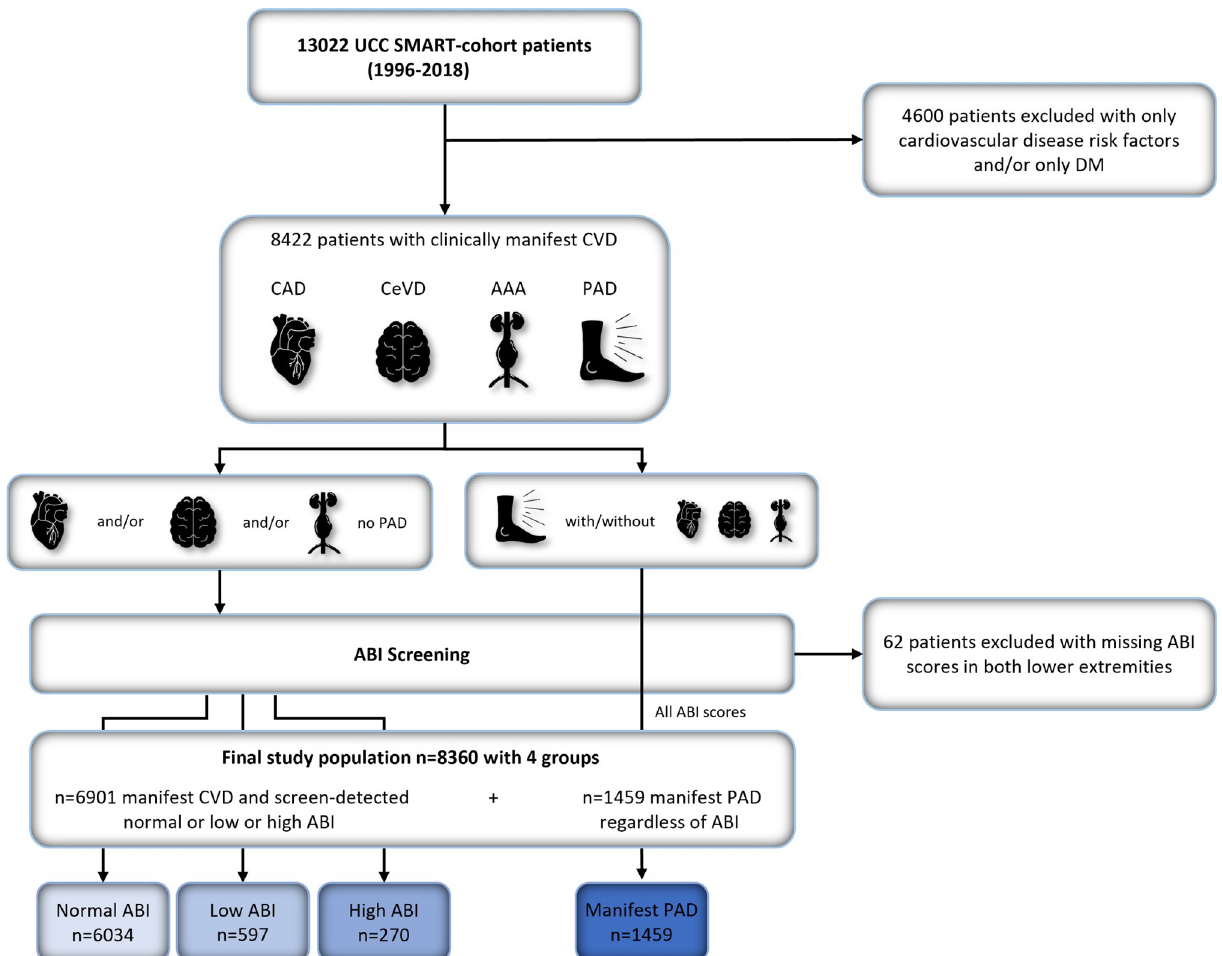
Fig 2. Flowchart of the study population. Abbreviations: UCC-SMART = Utrecht Cardiovascular Cohort Second Manifestations of ARTerial disease, DM = diabetes mellitus, CeVD = cerebrovascular artery disease, CAD = coronary artery disease, AAA = abdominal aortic aneurysm, PAD = peripheral arterial disease, ABI = ankle brachial